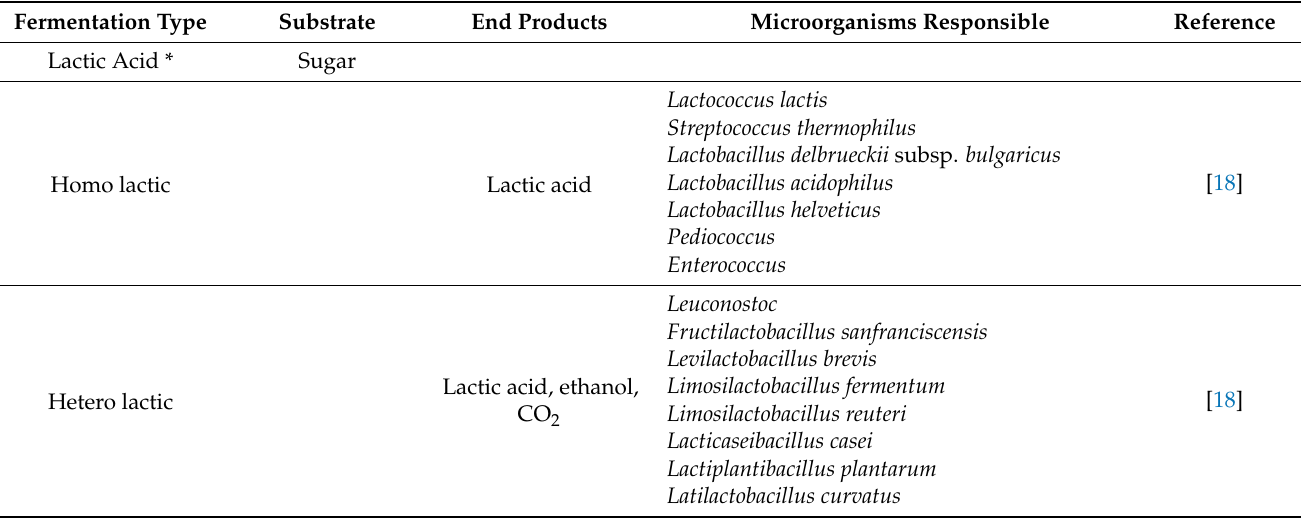
Table 1. A summary of the primary fermentation pathways of relevance to fermented foods, including the main fermentation end products and the microorganisms responsible for their